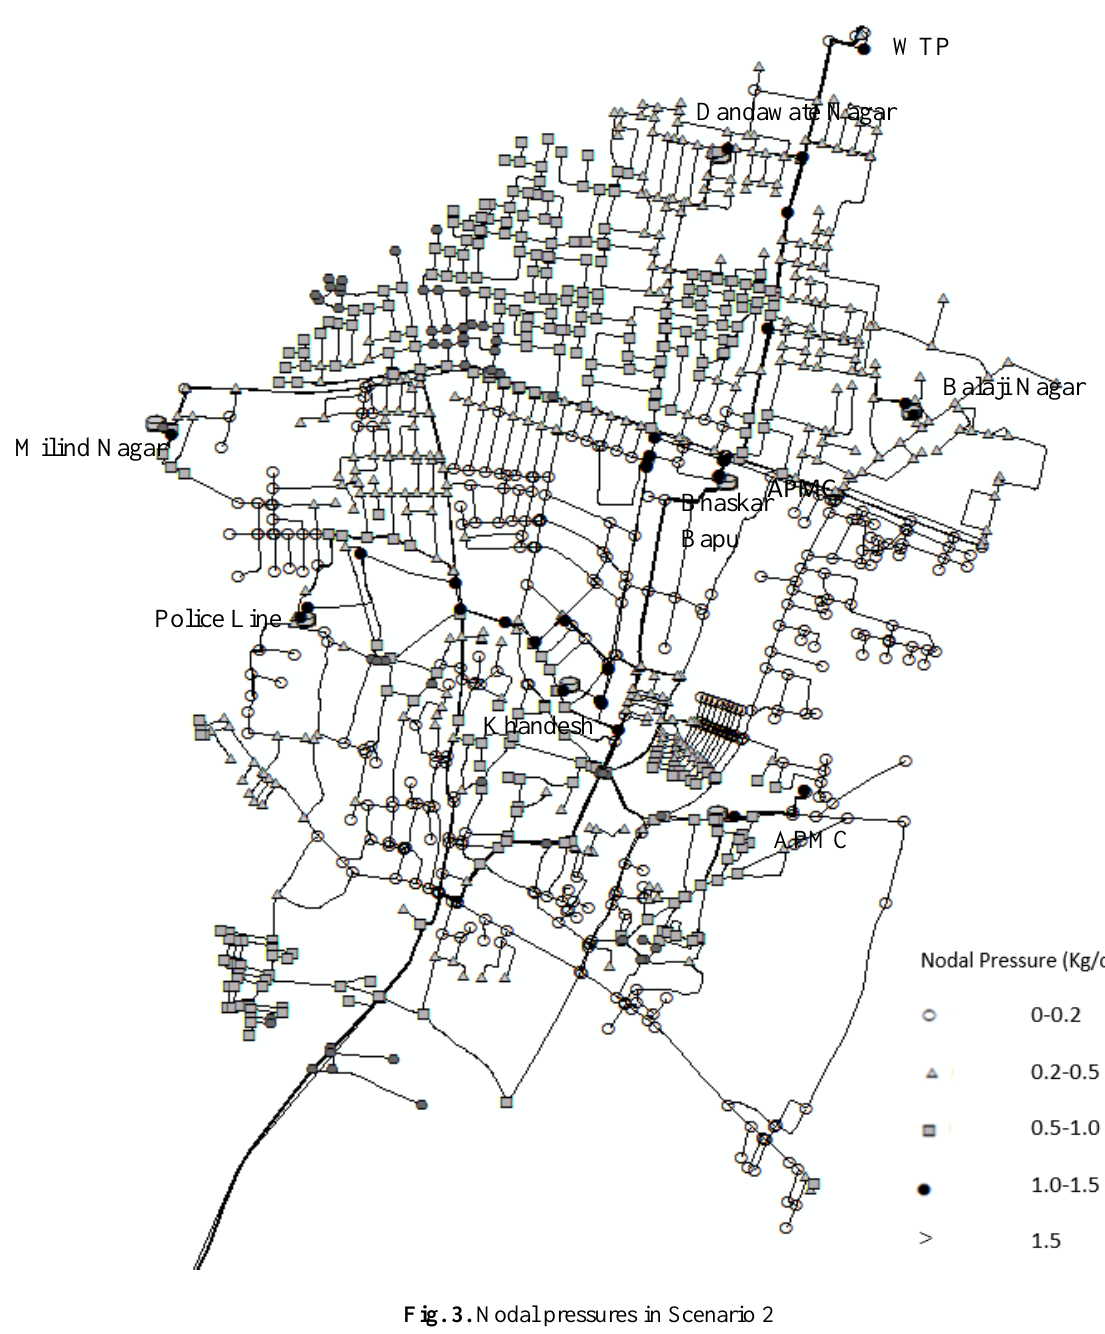
Fig. 3. Nodal pressures in Scenario